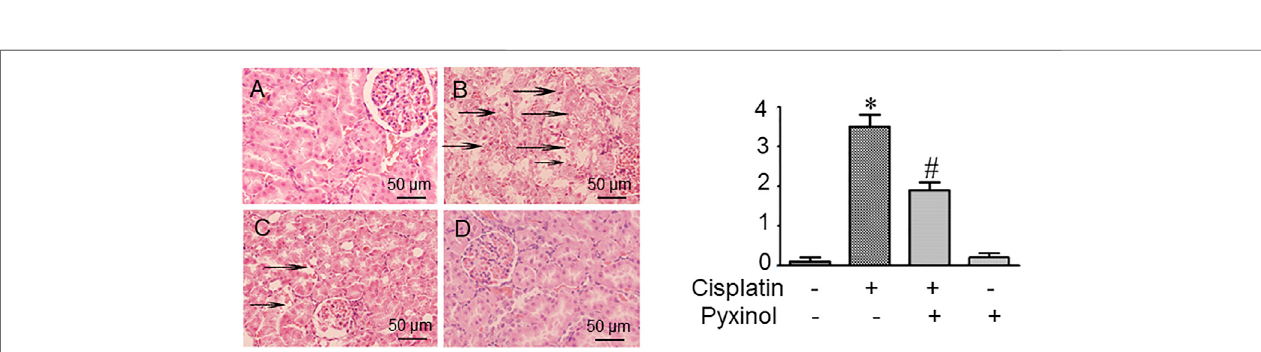
FIGURE 3 | Effects of pyxinol on the kidney histopathological damage induced by cisplatin in rats. Left: (A) Control group; (B) Cisplatin group; (C) Cisplatin plus pyxinolgroup; (D) Pyxinolgroup.Thedamagelevelsoftherenaltubuleswereblindlyassessedbasedona4-pointscale,andthescoreswereexpressedasmeans ± SD ( n (cid:1) 6). Representative histopathological changes were indicated using the black arrows: cell necrosis, cell swelling and vacuolization ( × 400 magni fi cations). Right: quanti fi cation of the histological damage. *p < 0.05, compared with the control group; #p < 0.05, compared with the cisplatin group.